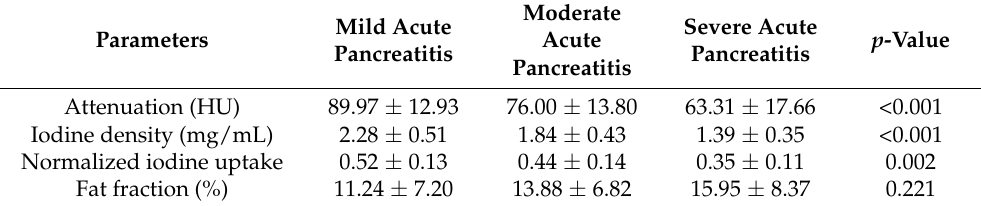
Table 2. Comparison of quantitative image parameters.